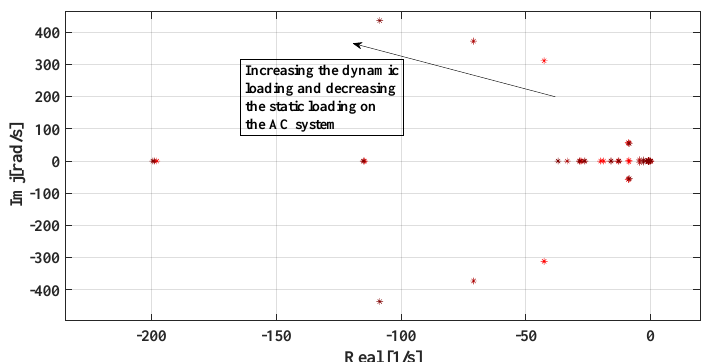
Figure 9. Eigenvalues with varying static AC loading.